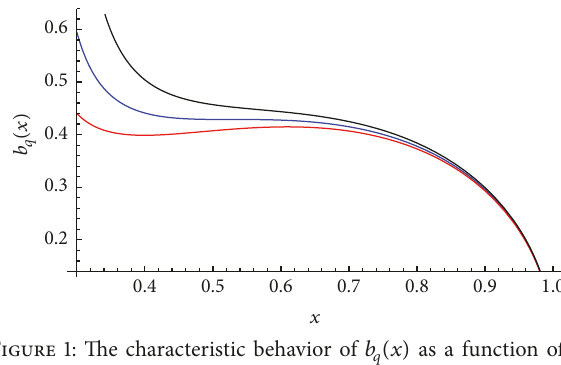
Figure 1: The characteristic behavior of 𝑏 𝑞 (𝑥) as a function of 𝑥 , when 𝑞 = 𝑞 𝑐 − Δ𝑞 (red), 𝑞 = 𝑞 𝑐 (blue), and 𝑞 = 𝑞 𝑐 + Δ𝑞 (black), with 𝑞 = √5 − 2 and Δ𝑞 = 0.03 . The blue curve in the middle represents 𝑐 the critical